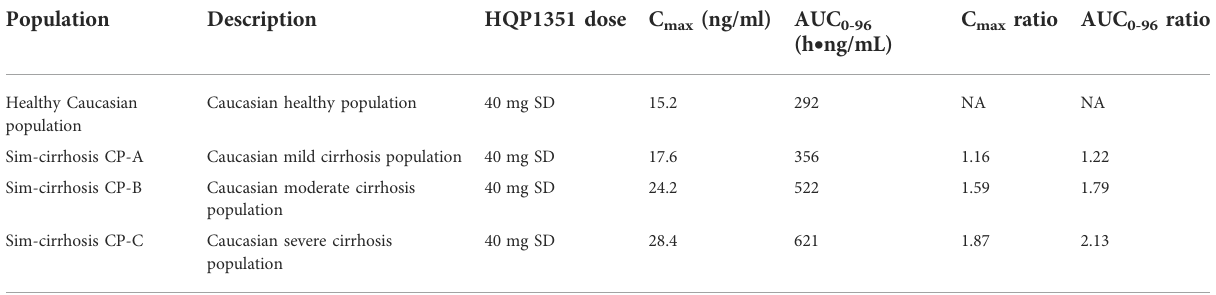
TABLE 3 Simulated C max and AUC 0-96 of olverembatinib (HQP1351) in different liver cirrhosis populations.